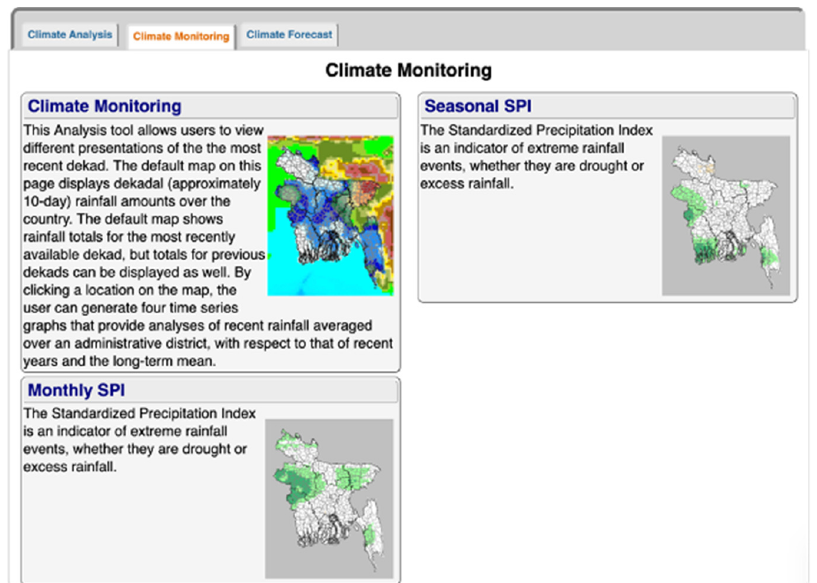
Figure 7. An example of the Climate Monitoring Maproom for Bangladesh. The map on the top left shows dekadal rainfall total for a given 10-day period, while the other two maps show monthly and seasonal SPI (Standard Precipitation Index), which is a measure of extreme wetness (green colors) or dryness (brown colors).